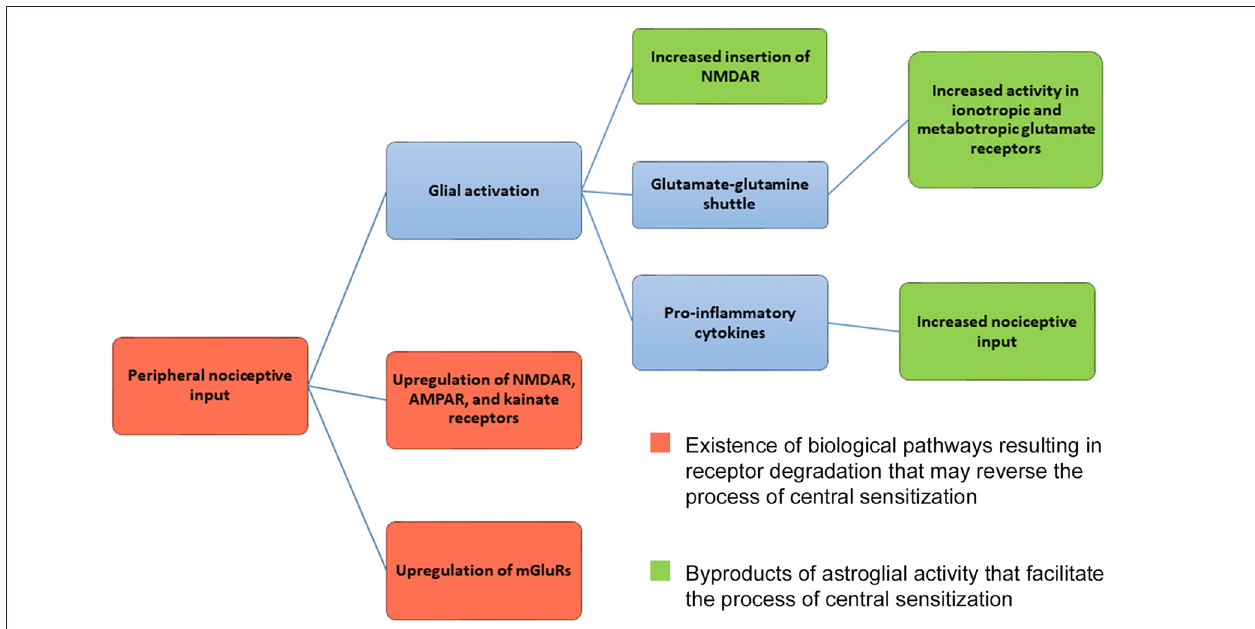
FIGURE 1 | Mechanism for central sensitization. Central sensitization (central nervous system hypersensitivity) is initiated from the upregulation of ionotropic glutamate receptors (NMDAR, AMPAR, kainite receptors) and metabotropic glutamate receptors (mGluRs) in the presence of peripheral nociceptive input. As a result, neurons in the dorsal horn of the spinal cord and central nervous system respond to nociceptive input at lower thresholds, with new enlarged receptor fields, and undergo increased rates of spontaneous firing. Glial activation can further maintain the mechanisms underlying central sensitization by increasing NMDAR and AMPAR insertion in postsynaptic membranes. Glial cells release pro-inflammatory cytokines, serving as further nociceptive input. Astroglial cells also help to maintain glutamate levels via the glutamate-glutamine shuttle, which can influence both ionotropic and mGluR activity. As shown in red, ionotropic, metabotropic receptors and nociceptors are capable of being degraded. Given that degradative pathways exist, the process of central sensitization can be reversed. Activity by astroglial cells, however, may mitigate the effects of receptor degradation by upregulating and facilitating the process of central sensitization. Given that central sensitization does not reverse itself with time, it seems that astroglial activity overpowers the existence of degradative receptor